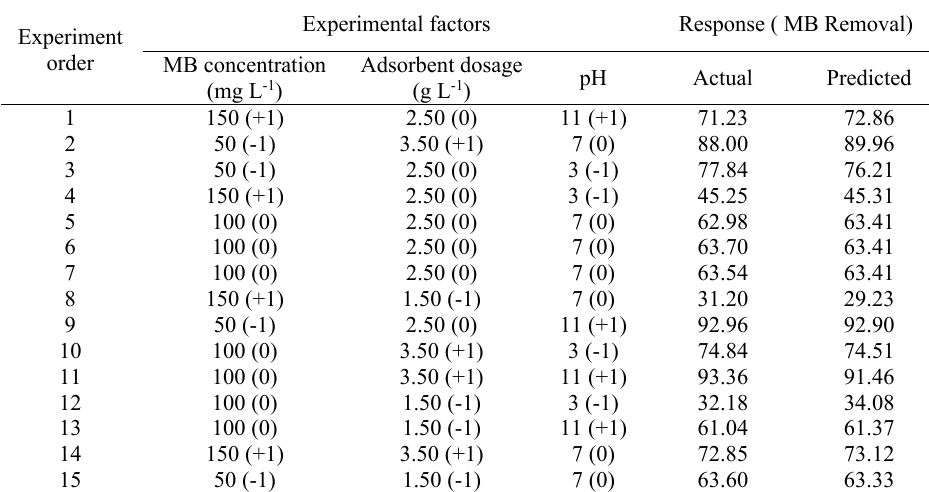
Table 3. Design matrix for experimental factors and response at different factor levels.